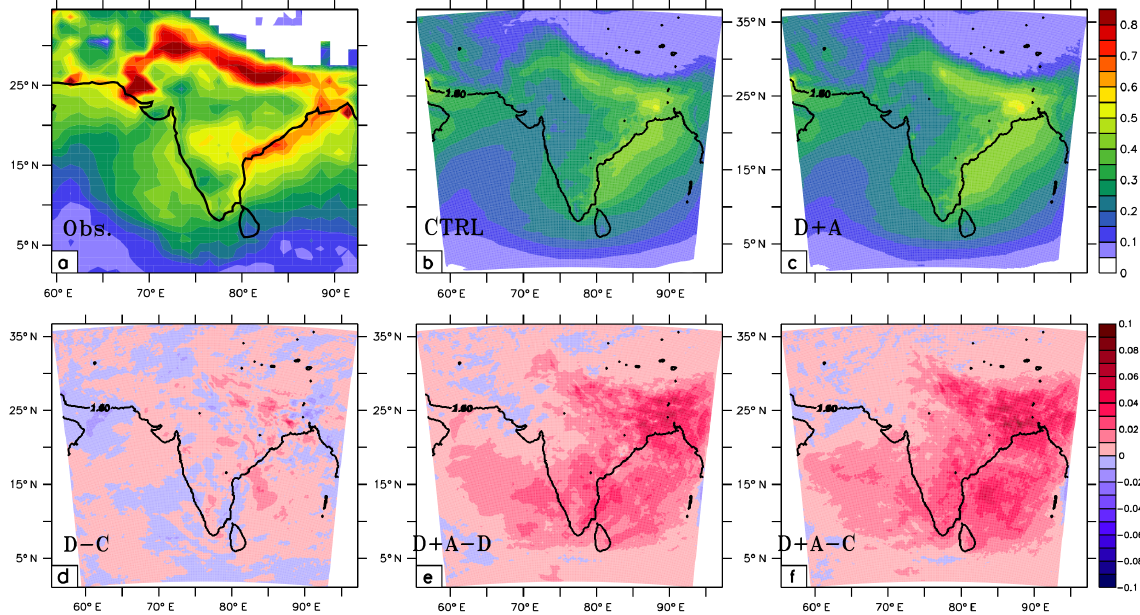
Figure 7. Comparison between (a) satellite-retrieved AOD (MODIS), (b) model-simulated AOD in the CTRL configuration and (c) model- simulated AOD in the DIEM+AF configuration. The bottom panels show the effects of the modifications in emissions on AOD simulations: (d) model-simulated AOD for the DIEM-CTRL configurations, which shows the effect of the prescription of the diurnal variation in emissions on AOD. (e) Model-simulated AOD for the DIEM+AF-DIEM configurations, which shows the effect of the prescription of the adjustment factor on emissions on AOD. (f) Model-simulated AOD for the DIEM+AF-CTRL configurations, which shows the effect of the prescription of both the diurnal variation and the adjustment factor on emissions on AOD. All the plots represent the month of May